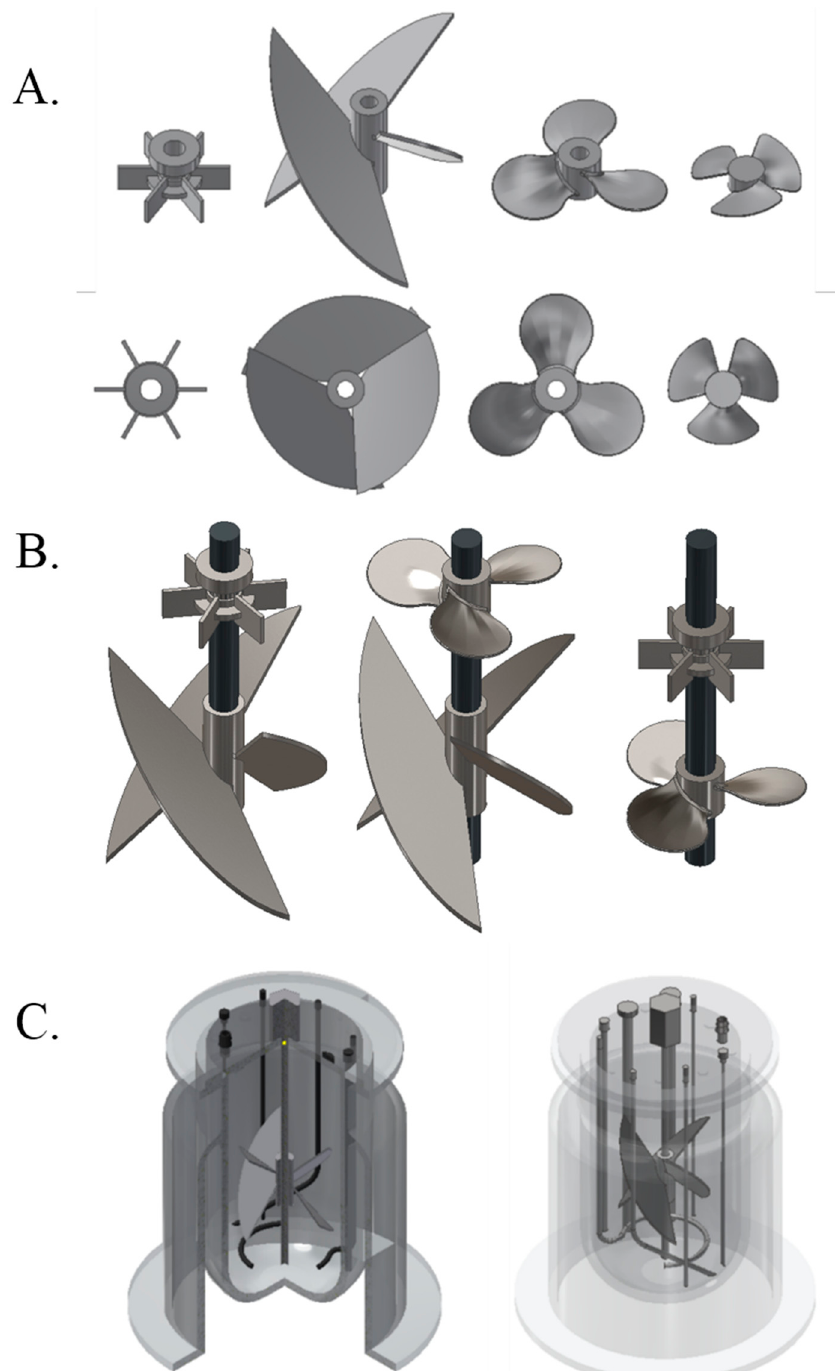
Figure 1. ( A ) Impellers used for this study (from left to right): Rushton (six-blade turbine), three-paddle helix impeller, Brunswick Bioflo / CelliGen 115 bioreactor default propeller and small propeller (abbreviated as S. Propeller). ( B ) The impeller combinations used (from left to right): Rushton–paddles, propellers–paddles, and Rushton–propeller. ( C ) The 3 / 4 section view 3D CAD models of: Brunswick Bioflo / CelliGen 115 bioreactor (left); and transparent view